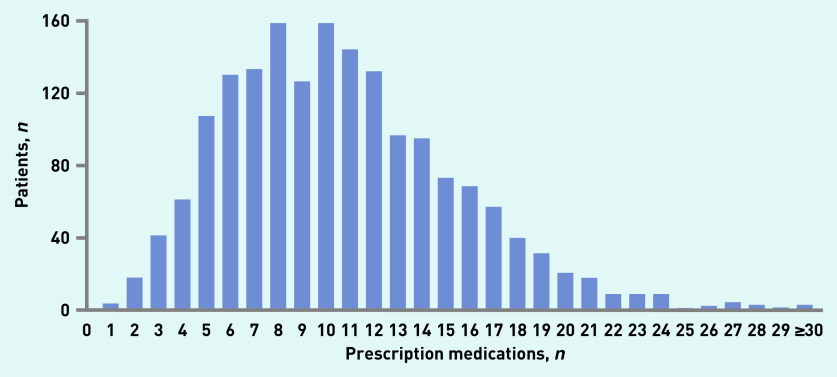
The distribution of total medication burden at baseline in patients with heart failure with preserved ejection fraction.